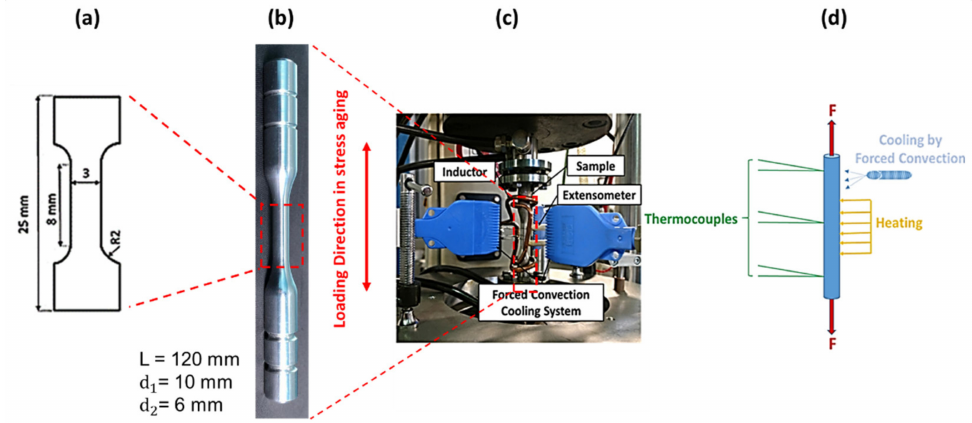
Figure 2. ( a ) Miniature flat samples cut from the initial gauge section for subsequent testing, ( b ) cylin- drical dogbone samples used for stress-aging, ( c ) photograph showing the stress-aging setup and ( d ) schematic detailing the